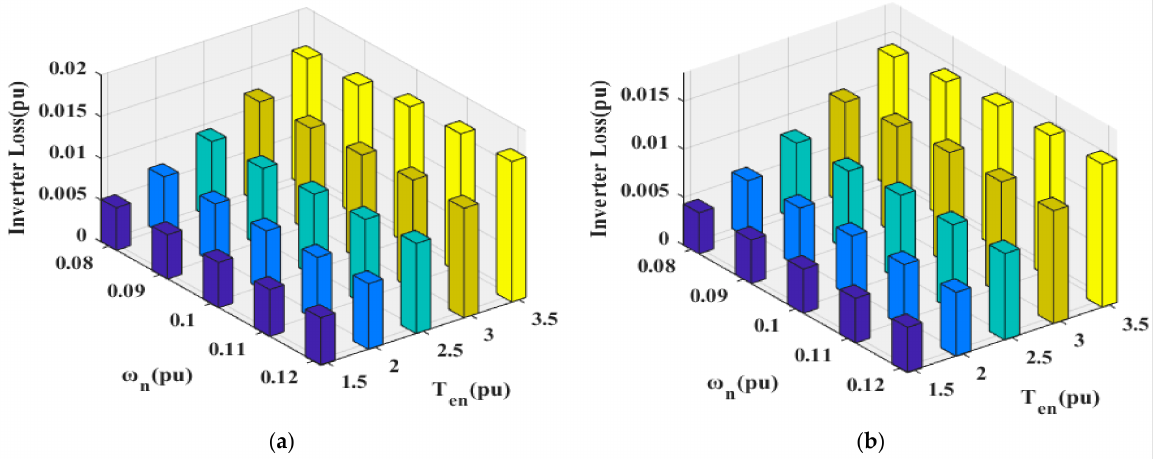
Figure 8. Inverter loss of traditional boost algorithm and the proposed boost algorithm of SVPWM modulation scheme ( a ) traditional algorithm ( b ) fixed SVPWM modulation